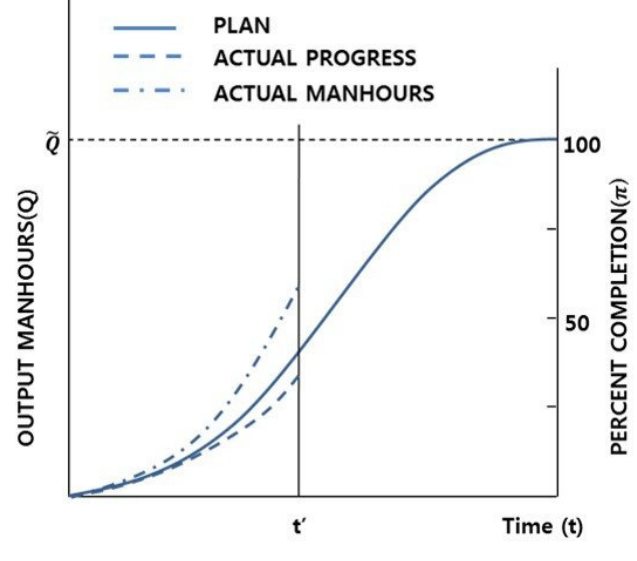
Figure 3. Sample ship block production progress